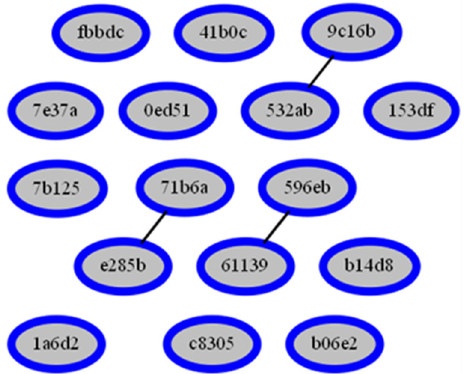
Figure 19. Ransomware binary samples Strings similarity graph.